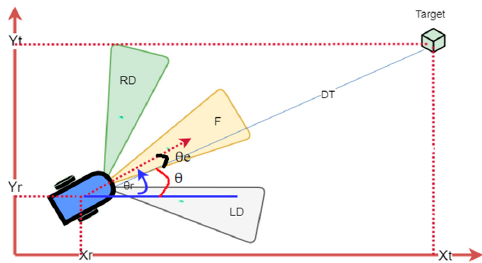
Figure 3. Tracking a virtual reference path (angle to goal ( θ = θ r − θ e ) .